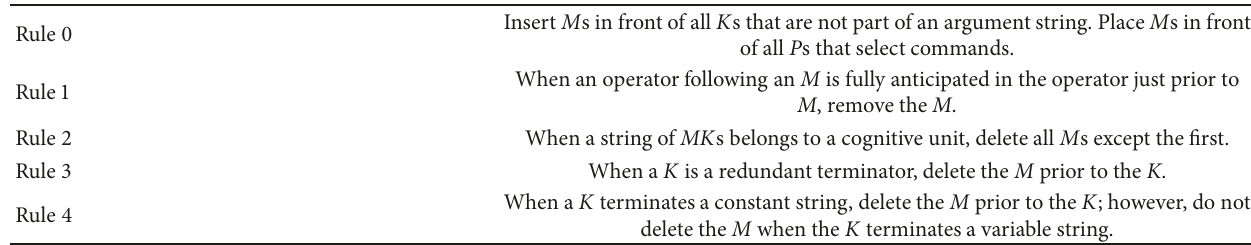
Table 2: Heuristic rules for M operator placement [6].